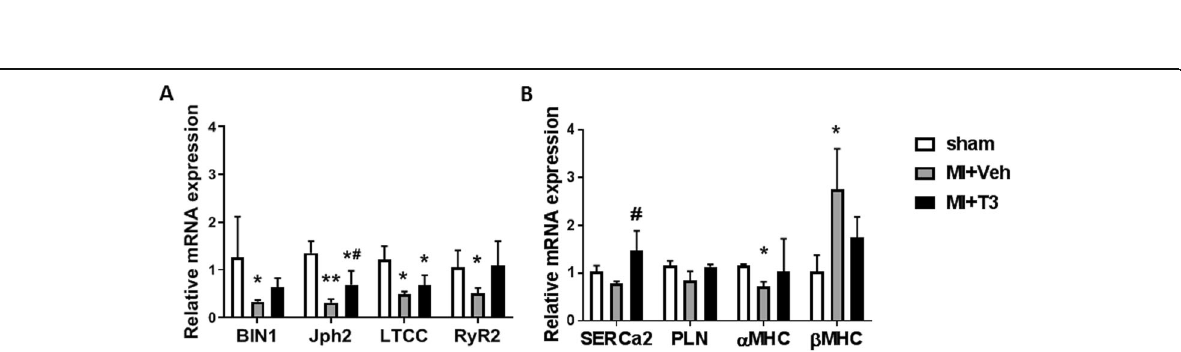
Fig. 4 Confocal imaging of cardiomyocyte T-tubule networks. a Representative images of cardiomyocytes from each study group labeled with di- 8-ANEPPS captured on a Leica LSM using a 63x objective. Scale bar = 10 um. b AutoTT quantitative analysis of di-8-ANEPPS images showing tubule densities as percent total number of pixels of skeletalized transverse-oriented tubules (TE%) or longitudinal-oriented tubules (LE%) divided by the total number of pixels of the region of interest (ROI). Each dot represents averaged values from one animal. Box-and-whisker plots show median value, box fences at 25th /75th percentiles, and whiskers at max/min values. c TT power analysis of di-8-ANEPPS images. Each dot is the average TT power value of 6 – 8 z-stacks captured per cell of ~ 10 cells per heart. Box-and-whisker plots as described in ( b ); n = 4 – 5 rats/group. d Representative images of cardiomyocytes labeled with AlexaFluor-488 conjugated wheat germ agglutinin (WGA-488) and images captured using Nikon C2 LSC microscope with 63x oil immersion objective. Scale bar, 10 um. e TT power quantitative analysis of WGA images. Each dot is the average TT power value of ~ 12 z-stacks captured per cell of 15 – 20 cells per heart. Box-and-whisker plots as described above; n = 6 – 7 rats/group. One-way ANOVA, with post-hoc Tukey analysis, p -values between groups are indicated